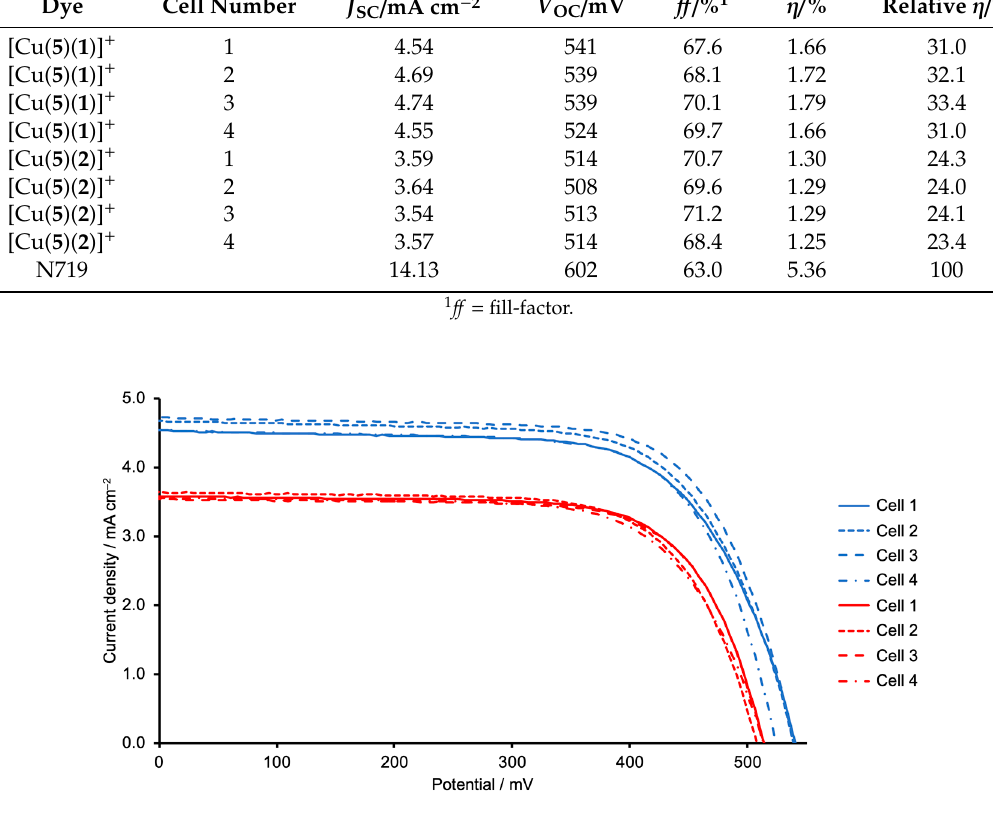
Figure 7. J–V ( J = current density, V = voltage) curves for sets of four dye-sensitized solar cells (DSCs) sensitized with [Cu( 5 )( 1 )] + (blue curves) and [Cu( 5 )( 2 )] + (red curves) measured on the day of sealing the cells. Table 1. Performance parameters (under 1 sun illumination) of duplicate, masked DSCs on the day of sealing the cells with the dyes [Cu( 5 )( 1 )] + and [Cu( 5 )( 2 )] + . The data are compared to a DSC containing N719 and relative η values are with respect to N719 set at 100%.